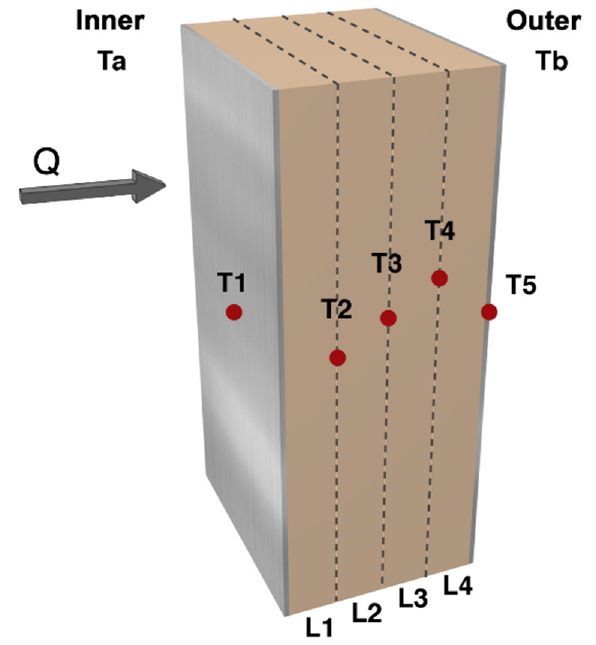
Figure 5. Schematic representation of test specimen, where Ta and Tb represent the thermocouples’ exterior positions (inside and outside the oven, respectively); Ti (I = 1 to 5) denotes the thermocouples in the panel; Li (i = 1 to 4) identifies the layers; and Q is the heat flux in the direction indicated by the arrow.